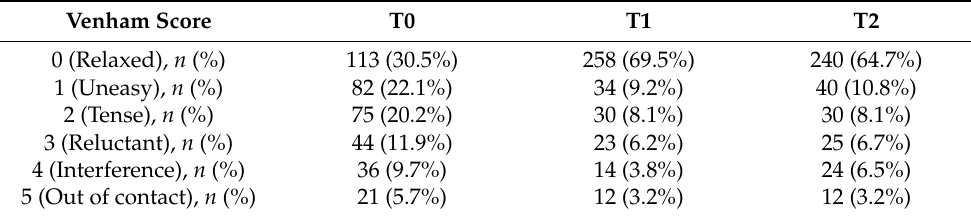
Table 3. Percentages of